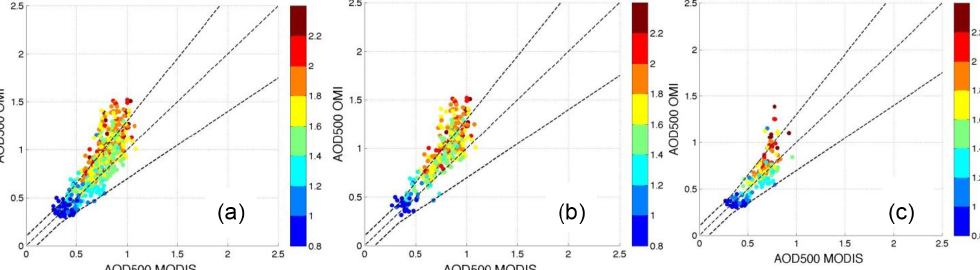
Figure 6. Comparison of OMI AOD 500nm and MODIS AOD 500nm colored by the corresponding AAI. OMI pixels have flag 0. (a) All points where a successful MODIS and OMI retrieval occurred regardless of the cloud fraction value in the MODIS retrieval. (b) Only points with CF>0.5. (c) Only points with CF<0.3.